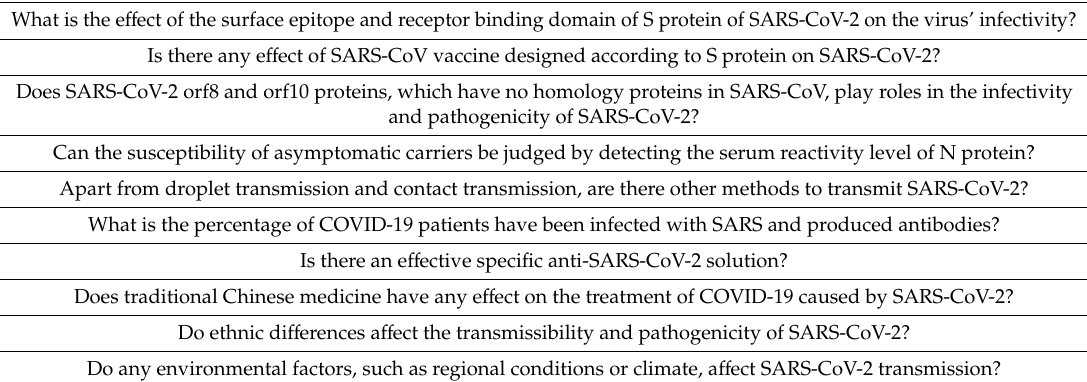
Table 3. Proposed questions to study SARS-CoV-2 for future studies.